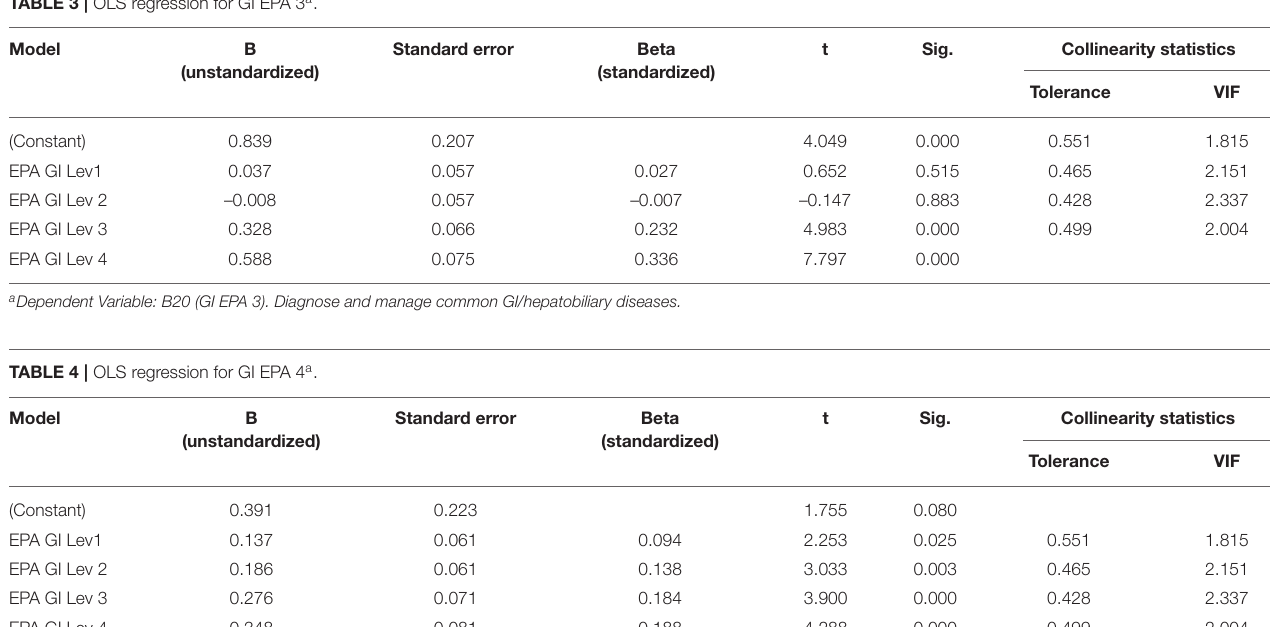
TABLE 3 | OLS regression for GI EPA 3 a .